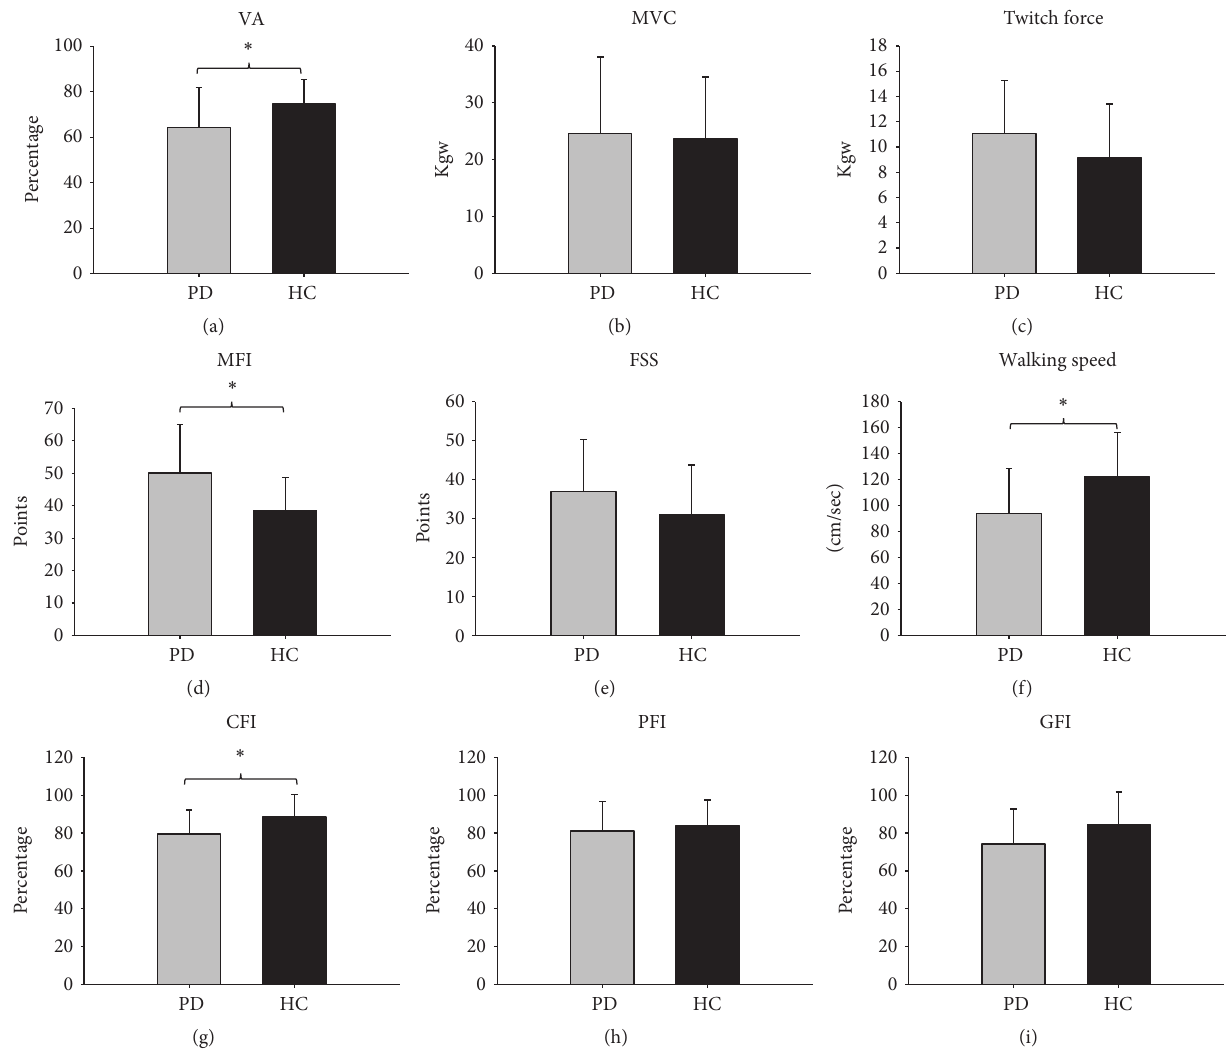
Figure 2: Differences between the PD and HC groups in (a) VA, (b) MVC, (c) twitch force, (d) MFI, (e) FSS, (f) walking speed test, exercise- induced (g) central fatigue, (h) peripheral fatigue, and (i) general fatigue indexes in the PD and HC groups. ∗ 𝑝 < 0.05 .